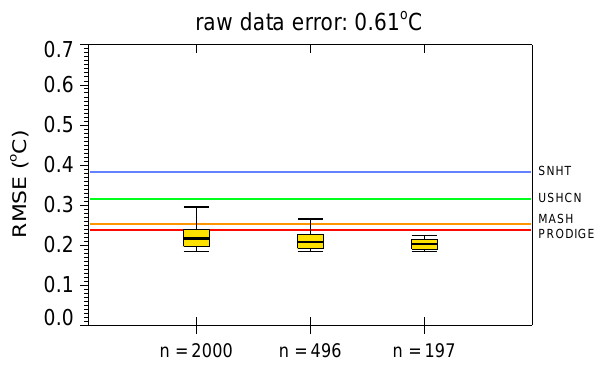
Figure 5. The same as Fig. 2, but for the RMSE of annual